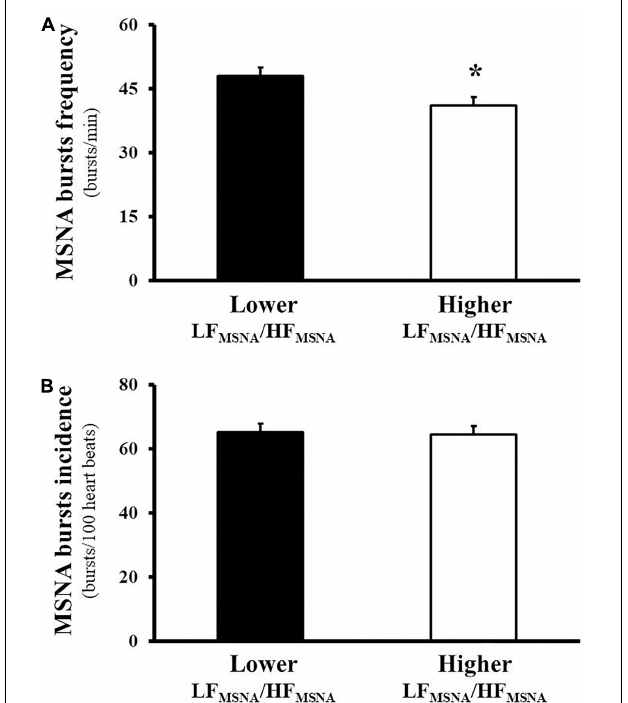
FIGURE 1 | Muscle sympathetic nerve activity (MSNA), assessed directly by the microneurography technique, in heart failure patients with reduced ejection fraction. The tonic activity of the MSNA reveals higher levels in burst frequency (bursts/min, A ) but not in burst incidence (bursts/100 heart beats, B ) in the Lower LF MSNA /HF MSNA group compared with the Higher LF MSNA /HF MSNA